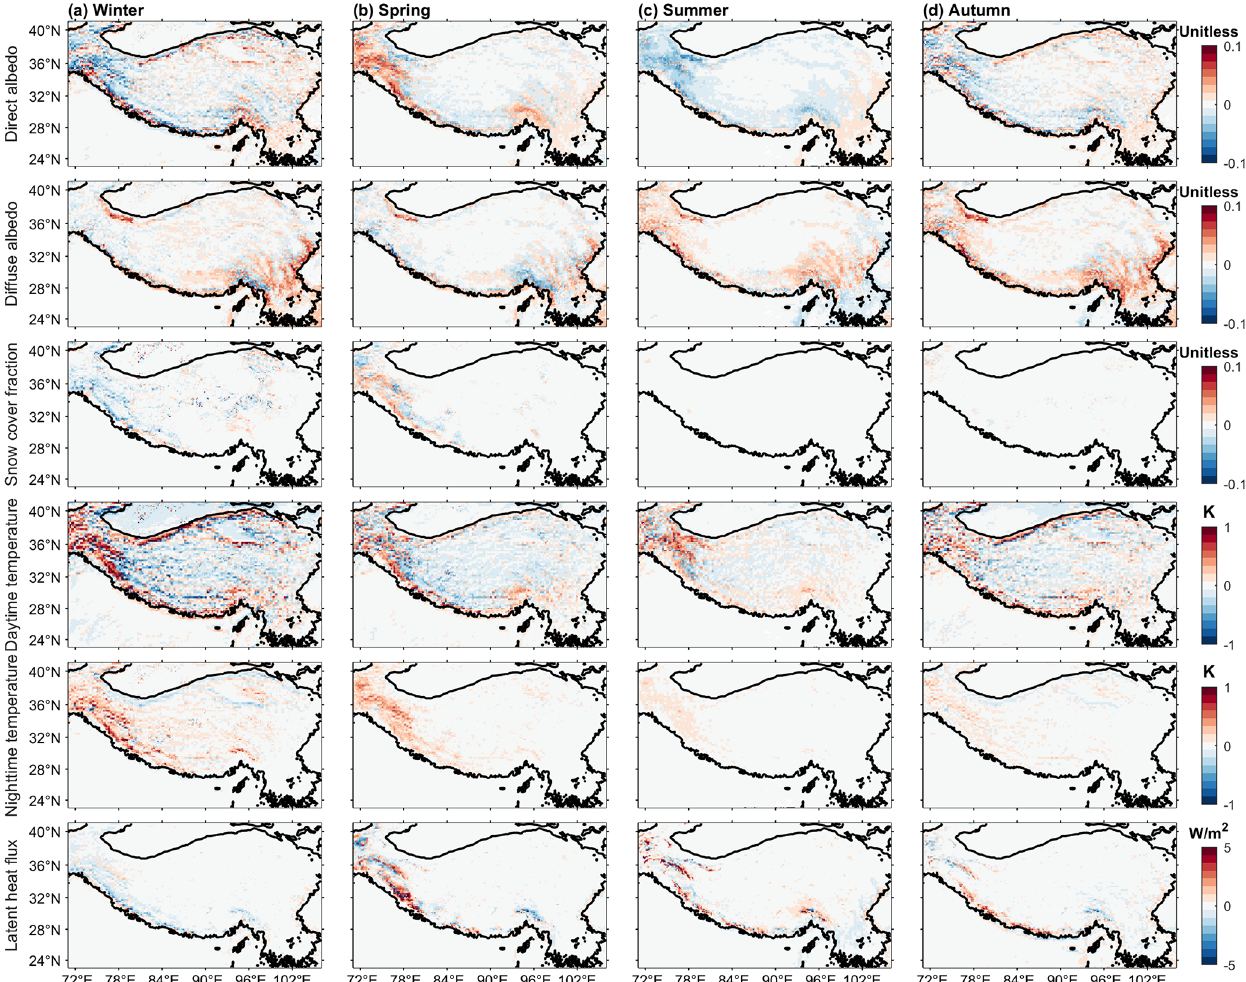
Figure 9. The change in the bias ( | δ TOP | – | δ PP | ) with respect to the MODIS data for four seasons in different variables (from top to bottom): direct albedo, diffuse albedo, snow cover fraction, daytime and nighttime surface temperature, and latent heat